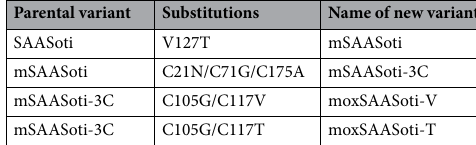
Table 2. Abbreviated names for the main SAASoti mutants discussed in the current